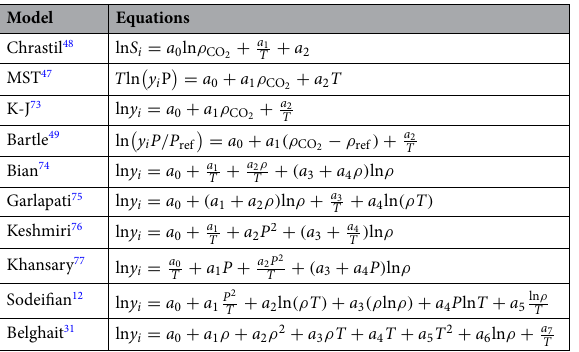
Table 3. Semi-empirical models. * S i : solubility in kg∙m −3 , y i : solubility in mole fraction, T : temperature in K, ρ : ScCO 2 density in kg∙m −3 , P : pressure in bar, a 0 ~ a 7 : adjustable model parameters, P ref : reference pressure (= 1 bar), ρ ref : reference density (= 700 kg∙m −3 ).